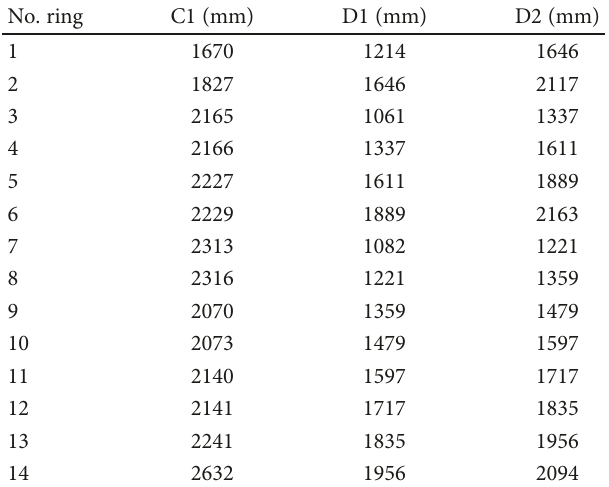
Table 6: Geometric dimensions of corresponding panels for each